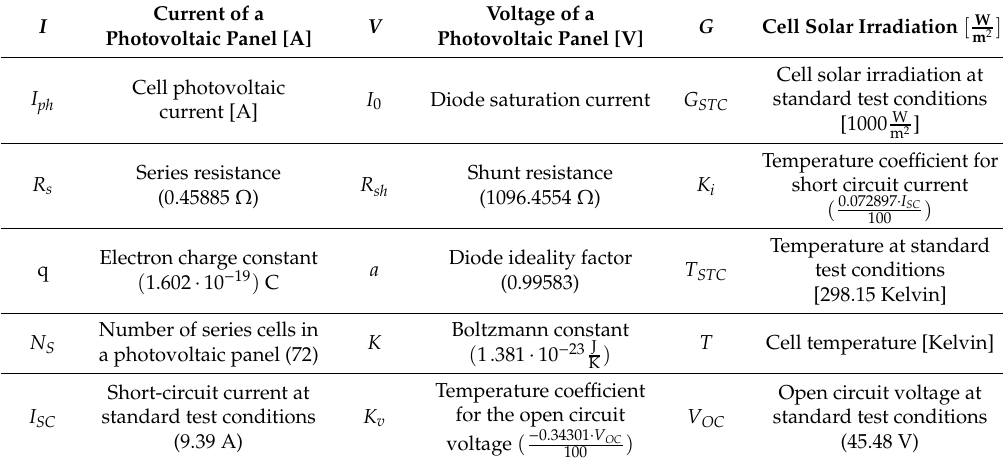
Table 1. Table comprising the parameters of the photovoltaic panel.